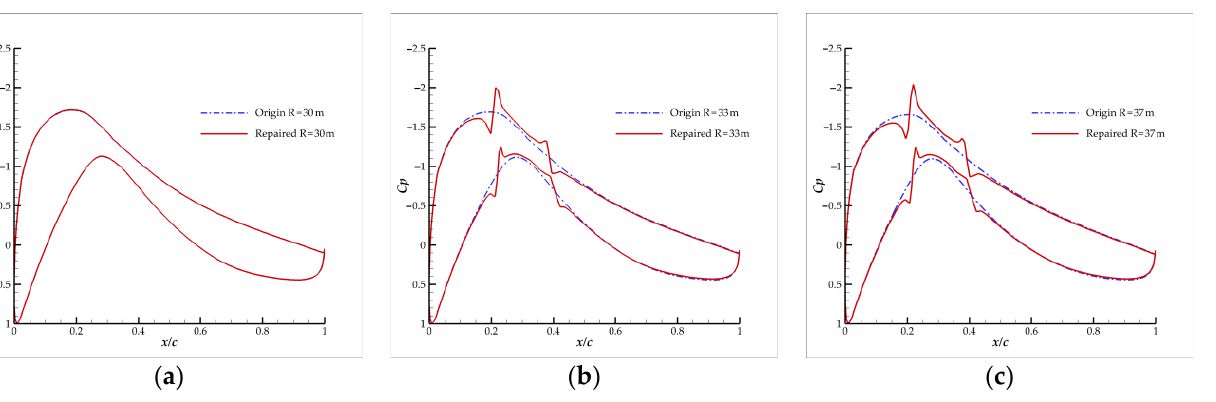
( b ) Figure 25. Flow field of the blade cross-section for R = 37 m: ( a ) the original blade; ( b ) the repaired blade.